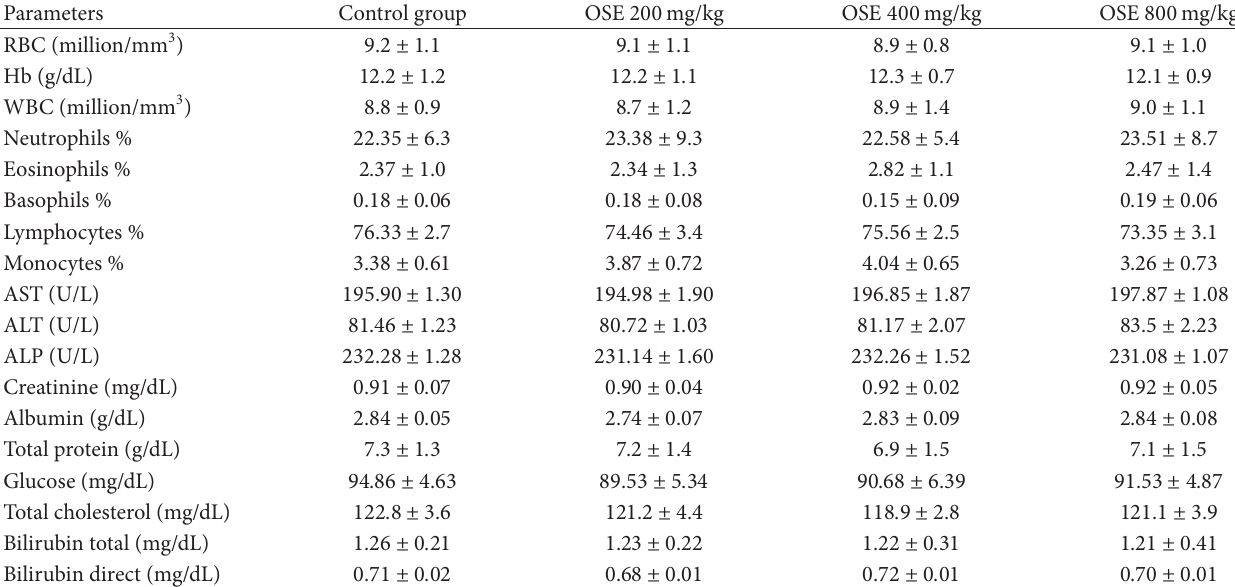
Table 3: Effect on hematological and biochemical parameters after 28 days of the oral administration of OSE. Parameters